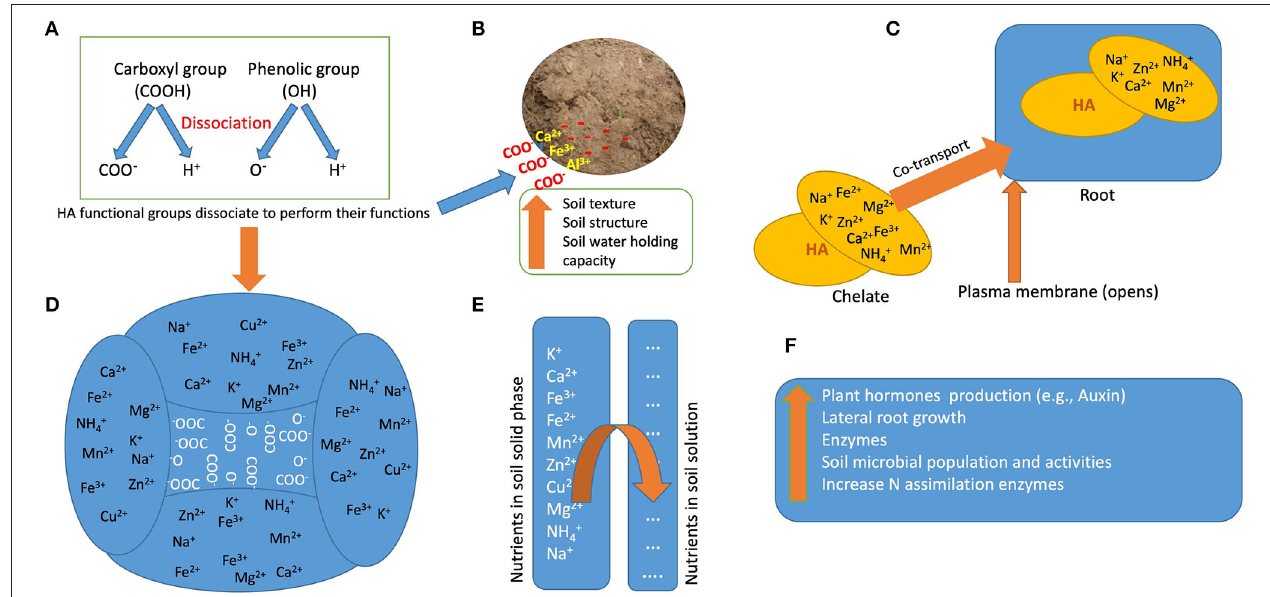
FIGURE 2 | Model summarizing the mechanisms and functions of humic acids (HA) in soils and plants; (A) dissociation of functional groups of HA; (B) hydrophilic ends of dissociated groups form a bridge between metal ions and soil surface; (C) humic acids chelate cationic nutrients and transport them through root’s plasma membrane; (D) hydrophilic ends of dissociated group attract cations (increase soil cation exchange capacity); (E) humic acids replenish nutrients in the soil solution (increase soil buffering capacity); (F) other functions of